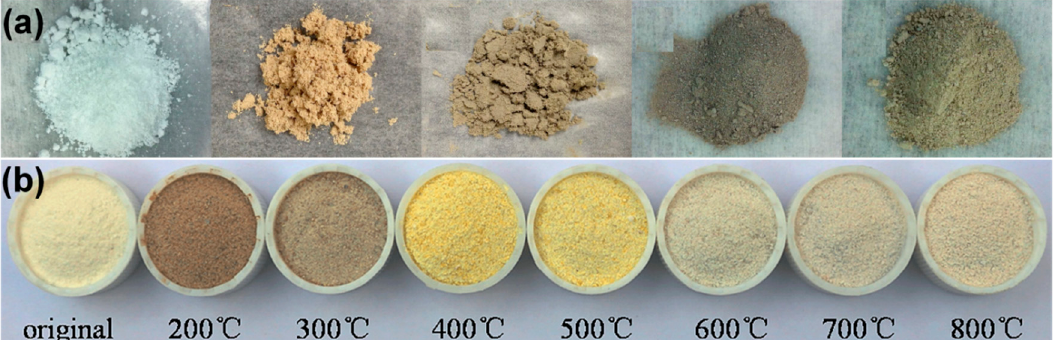
Figure 20. Photographic images of the ( a ) chemically reduced TiO 2 with increasing concentration of NaBH 4 and ( b ) hydroxylated and N-doped anatase TiO 2 that were derived from the amorphous hydrate TiO 2 at the increasing processing temperature (reproduced with permission from refs. [239,240]).